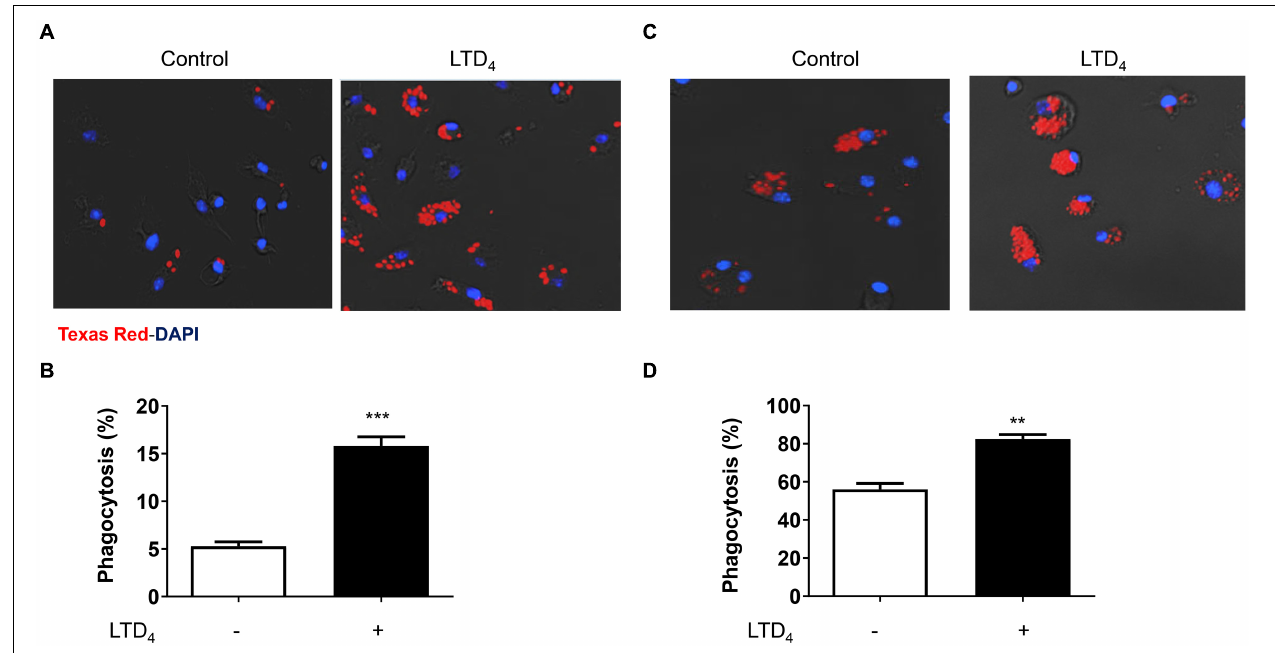
FIGURE 2 | Cys-LTs enhance phagocytosis in macrophages. Fluorescence micrographs showing zymosan particle phagocytosis in (A) raw macrophages and (C) BMDMs. Macrophages were treated with 0.5 µ M LTD 4 for 24 h and incubated with zymosan particles (1:10) for 1 h. Images were quantified using ImageJ. Panels (B,D) represent the quantification of raw macrophages and BMDMs, respectively. The results shown are mean ± SEM from three experiments performed (Student’s t -test, ** p ≤ 0.01 *** p ≤